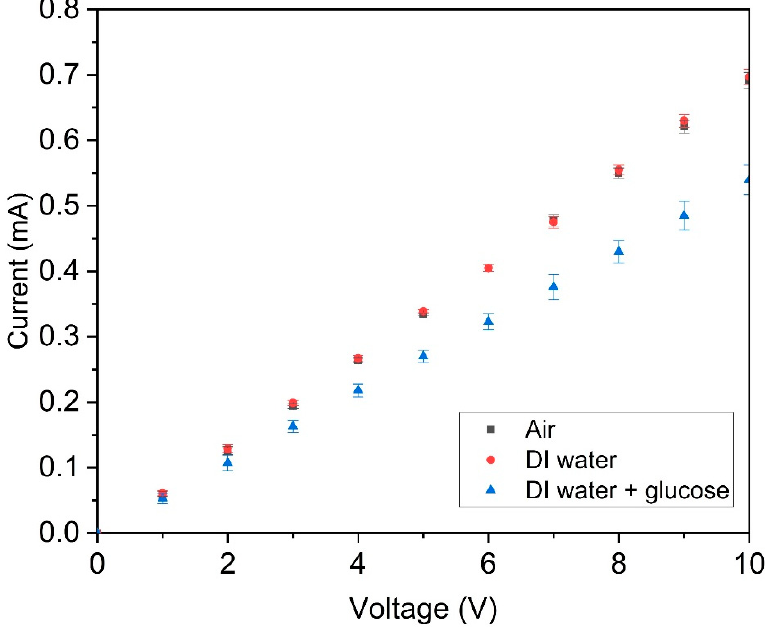
Figure 5. I-V curve of the PANI paper sensors. Each point represents an average of measurements of three identical PANI paper strips. The error bars represent the standard deviations of the three measurements. The black square, red circle and blue triangle represent the measurements under air, DI water and 12 mM of glucose in DI water.